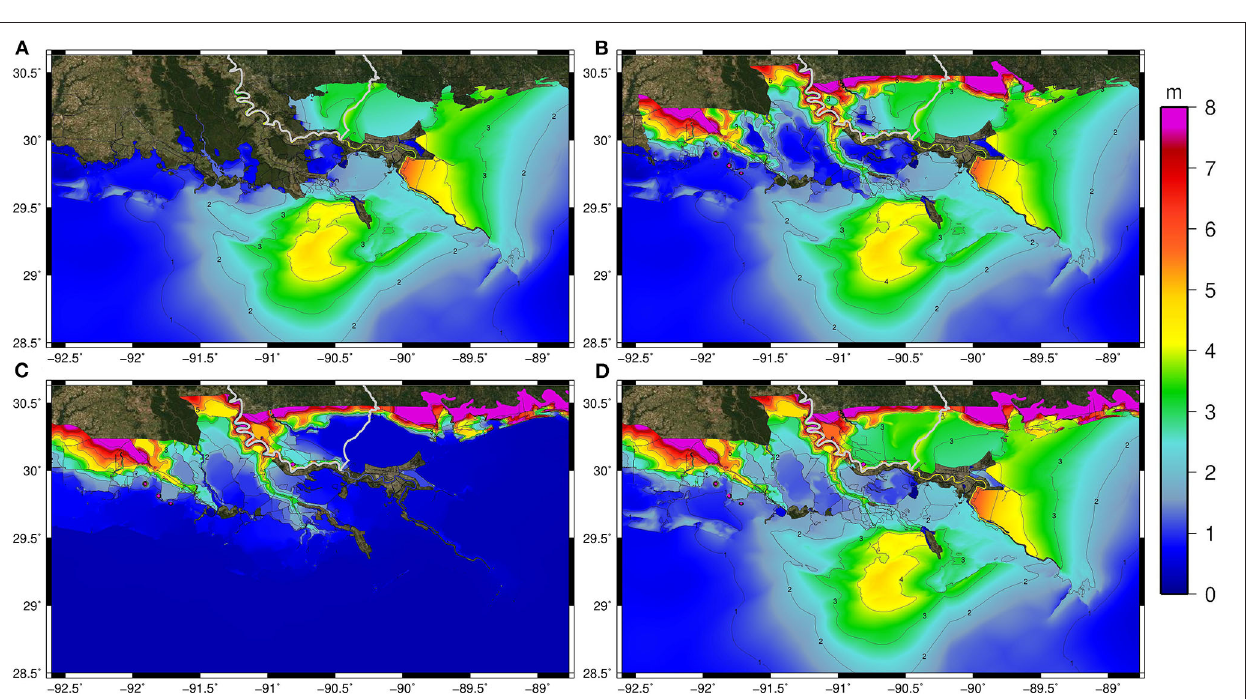
FIGURE 11 | Maximum of maximums (MOM) simulated peak water levels (m, NAVD88) for the Lake Maurepas 100-year TC events from (A) storm surge only (no rainfall), (B) storm surge and TC-driven rain, (C) antecedent rainfall only (no storm surge), and (D) antecedent rainfall, TC-driven rainfall, and storm surge in a single